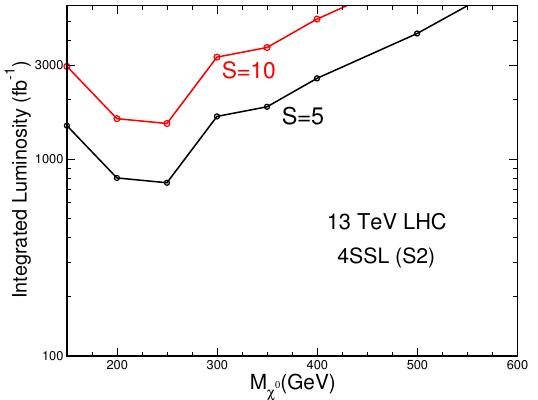
5). Note that the results remain (cid:21)